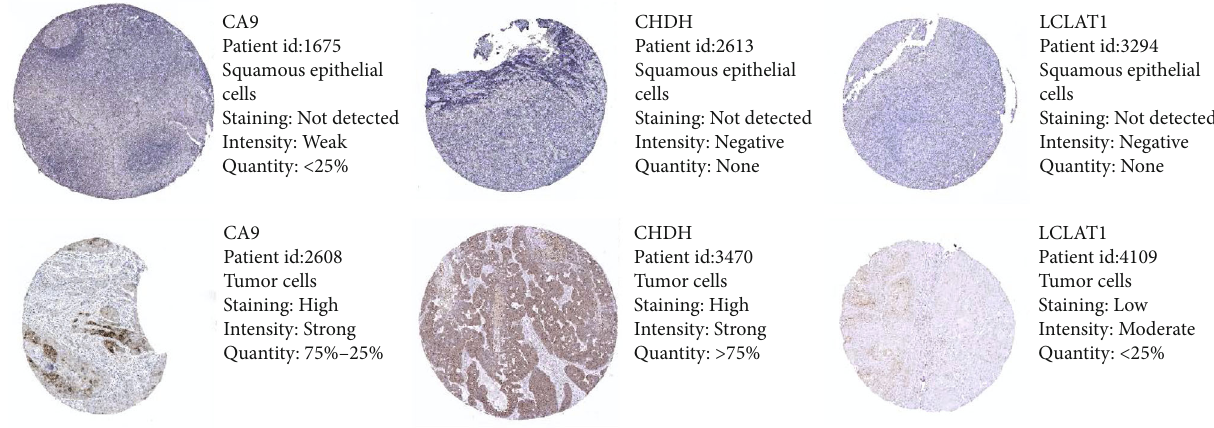
Figure 9: Representative protein expressions of CA9 , LCLAT1 , and CHDH were explored in the HPA database.